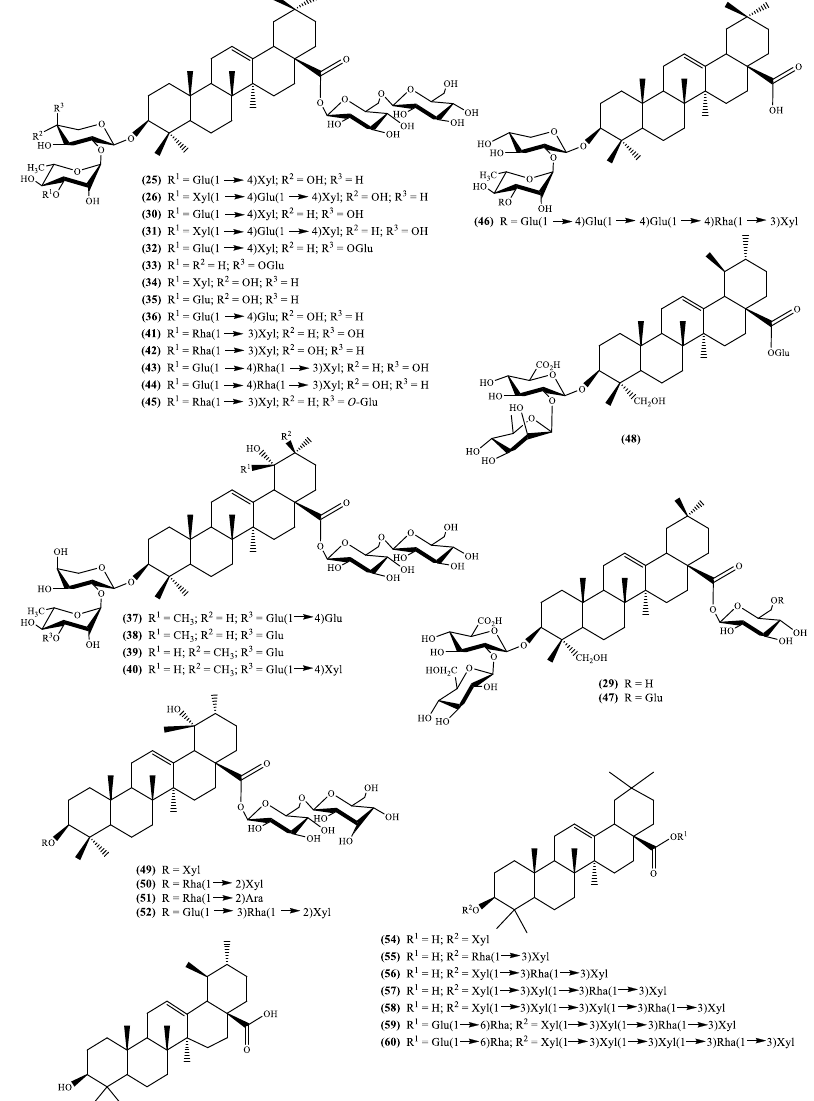
Figure 4. Pentacyclic triterpenoids isolated from the genus Scabiosa (Ara = arabinose; Gal = galactose; Glu = glucose; Rha = rhamnose; Xyl = xylose).